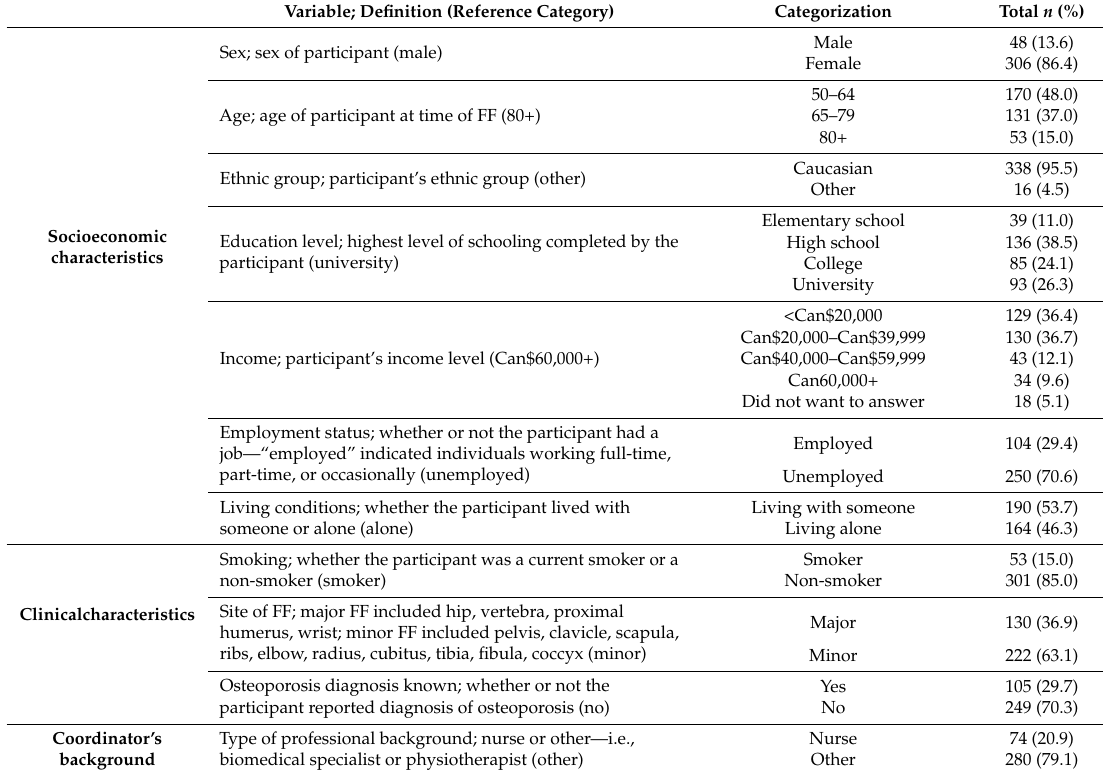
Table 1. Participants’ characteristics at baseline ( n = 354). FF: fragility